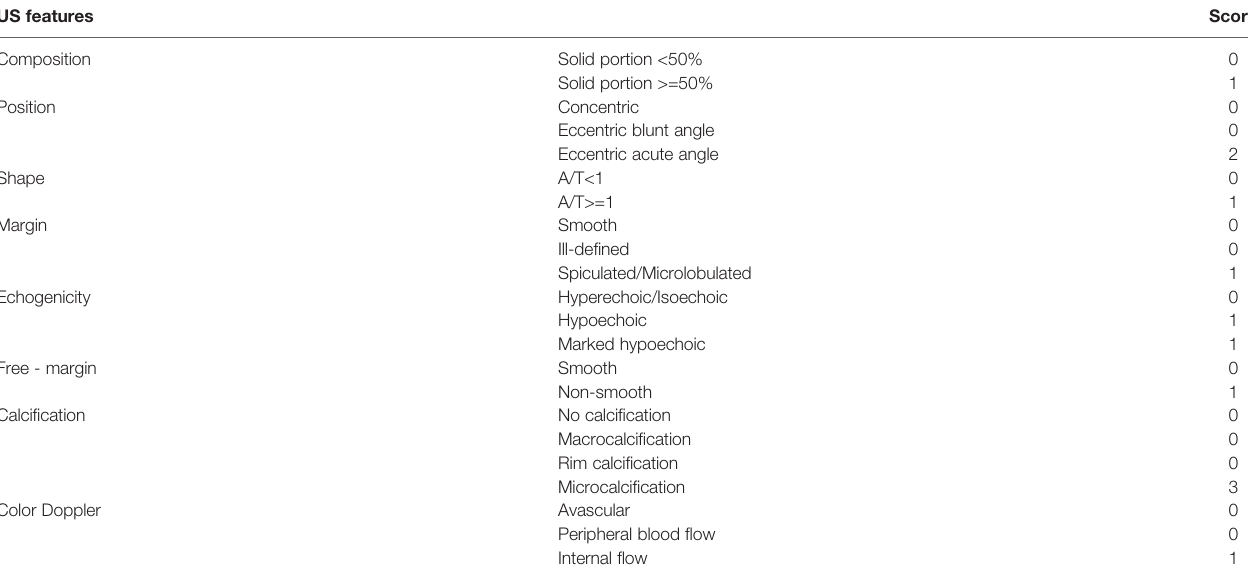
TABLE 2 | Scoring table of the scoring